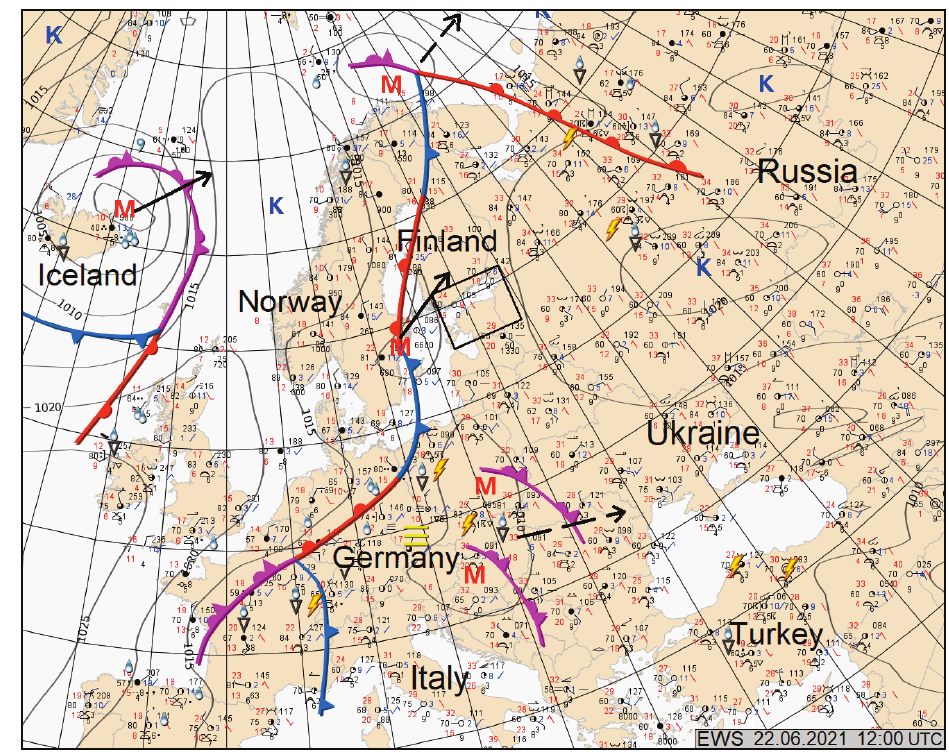
Fig. 4. A weather forecast map fragment (courtesy of the EWS) illustrating meteorological conditions together with high (K) and low (M) pressure systems during the heat wave on 22 June 2021. On 23 June, record-breaking air temperatures in Estonia were registered; thereafter, a front from the weak low-pressure system (centre near Stockholm) crossed Estonia and ended the heat wave episode by 24 June (see Fig. 5). Arrows indicate movements of the lows over 24 h (by 23 June); dashed arrows – dissipation of the cyclones. The study area is marked with a